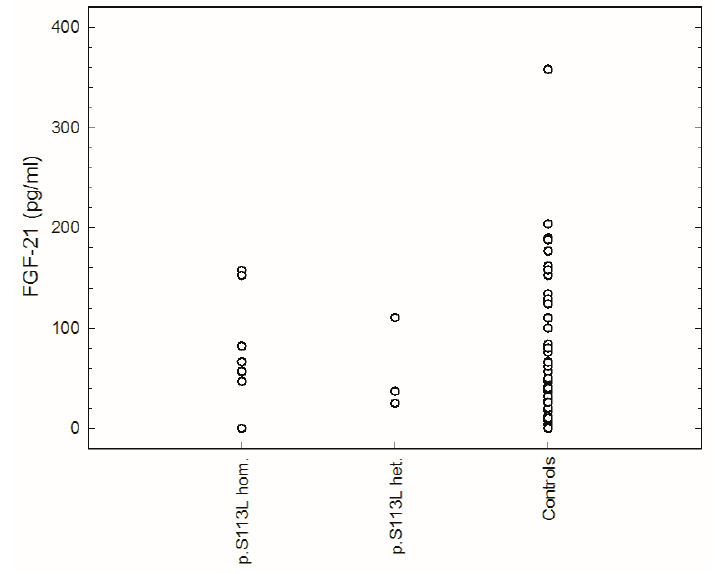
Figure 1. Fibroblast growth factor 21 (FGF-21) serum concentration in controls and patients with carnitine palmitoyltransferase II (CPT II) deficiency (p.S113L hom.: patients homozygous for the common p.S113L mutation; p.S113L het.: Patients with p.S113L on one allele and another mutation on other allele. The detailed genotype of all patients is illustrated in Table